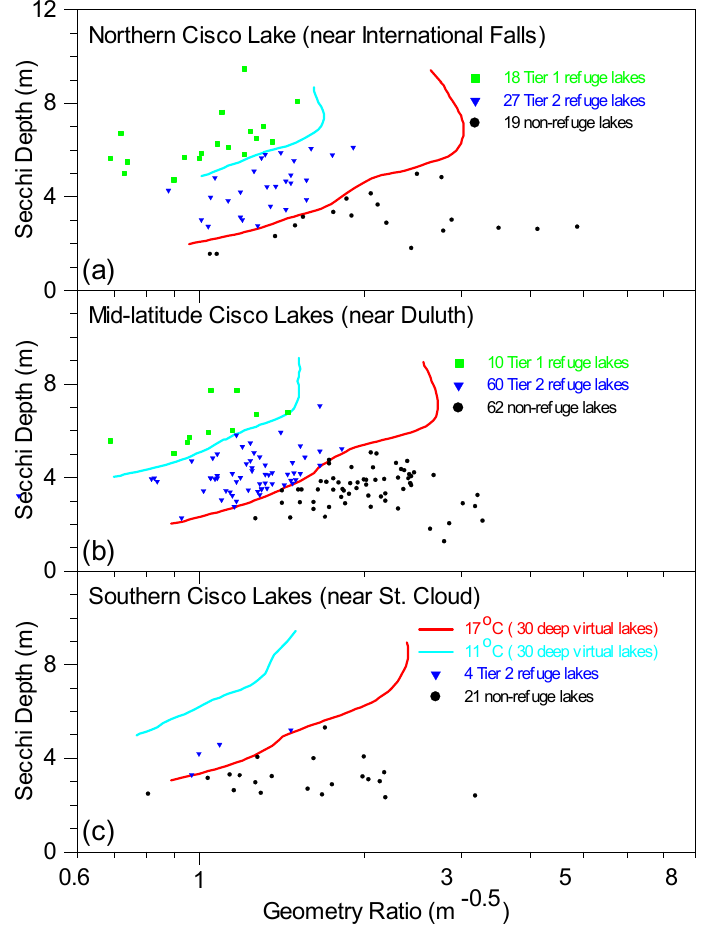
Figure 11. Distribution of Tier 1 and Tier 2 refuge lakes, and Tier 3 non-refuge lakes out of 221 deep cisco lakes using Secchi depth and lake geometry ratio as axes. The boundary contour lines of AvgATDO3 VB were derived for variable benchmark periods simulated for the 30 deep virtual lakes under MIROC 3.2 future climate scenario. ( a ) International Falls; ( b ) Duluth; and ( c ) St. Cloud weather data were used for the model simulations.